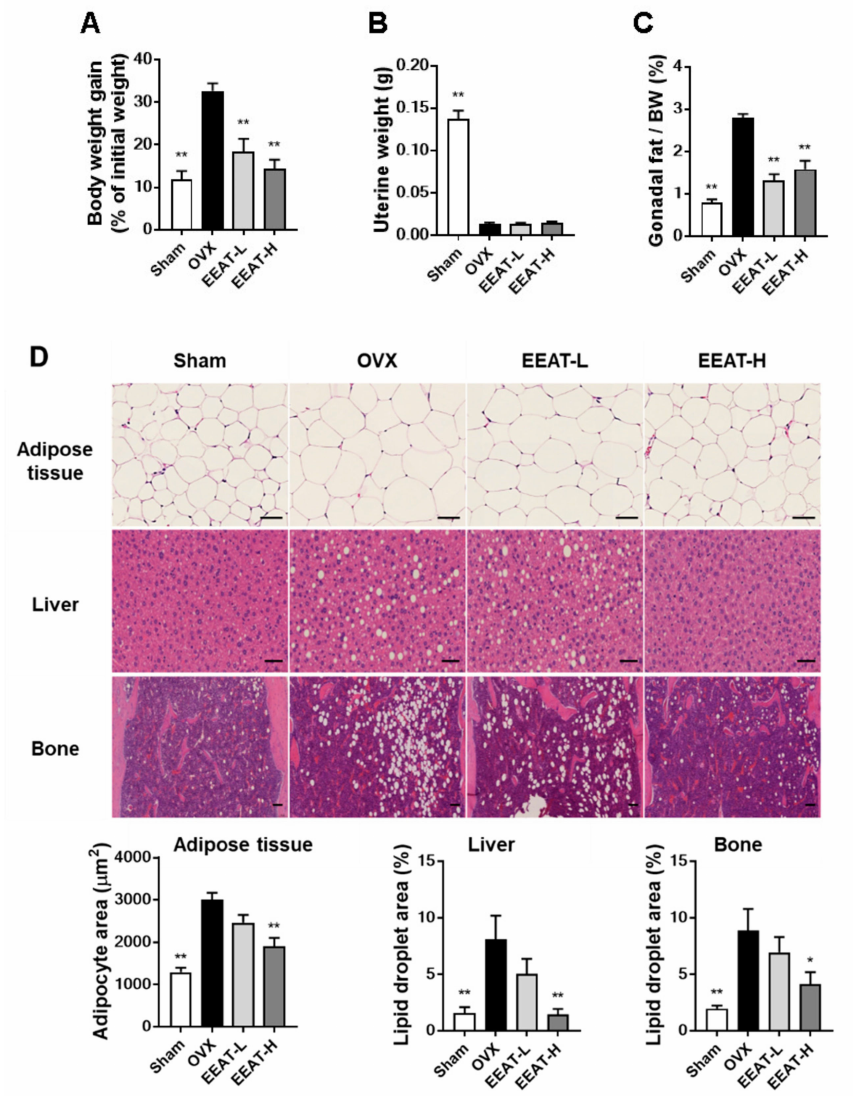
Figure 4. Ethanol extract of Amomum tsao-ko (EEAT) attenuates ovariectomy (OVX)-induced fat accumulation. Sham or OVX mice were orally received the vehicle or different doses of EEAT (30 or 100 mg/kg). After five weeks of administration, ( A ) body weight gain during EEAT administration period was assessed. Mice were euthanized, and then weight change of ( B ) uterus or ( C ) gonadal fat was quantified. ( D ) Isolated tissues were fixed and stained by hematoxylin and eosin staining solution (scale bar, 50 µ m). Histological image of the adipocyte area or lipid droplets in each tissue was analyzed, and representative images are shown. * p < 0.05, ** p < 0.01 versus OVX